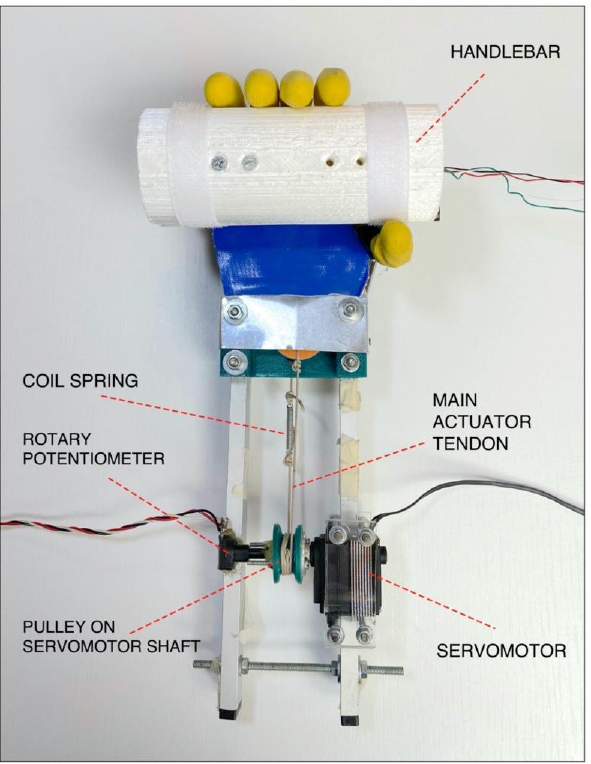
Figure 5. “Federica” hand while grasping the cylindrical handlebar during the performed grip